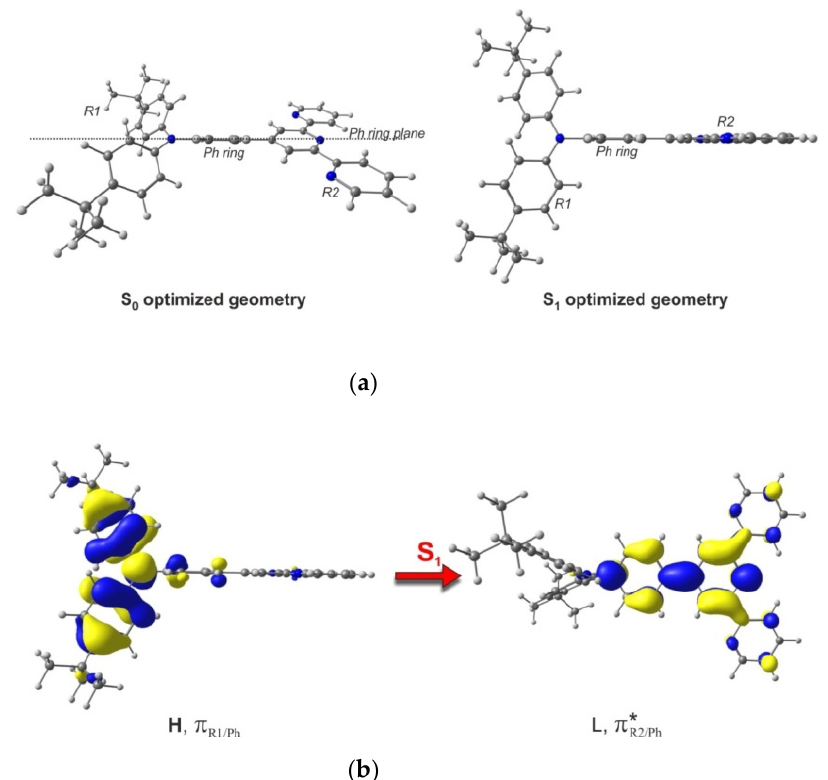
Figure 11. ( a ) tBuTPAterpy geometry changes as a result of the excitation and structural relaxation of the S 1 state; ( b ) Character of the electronic transition for the S 1 excited state in its optimised geometry. H and L are used as abbreviations for HOMO and LUMO, respectively.